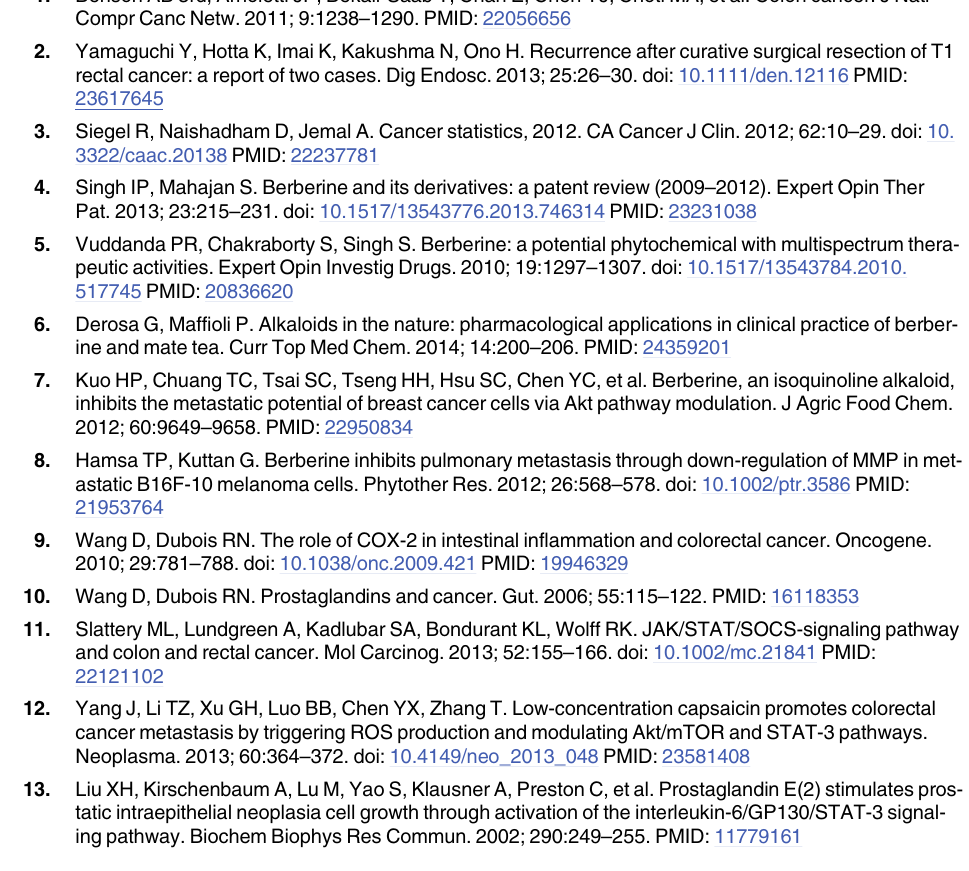
S1 Table. Effect of berberin on liver and kidney functions (means±SD).